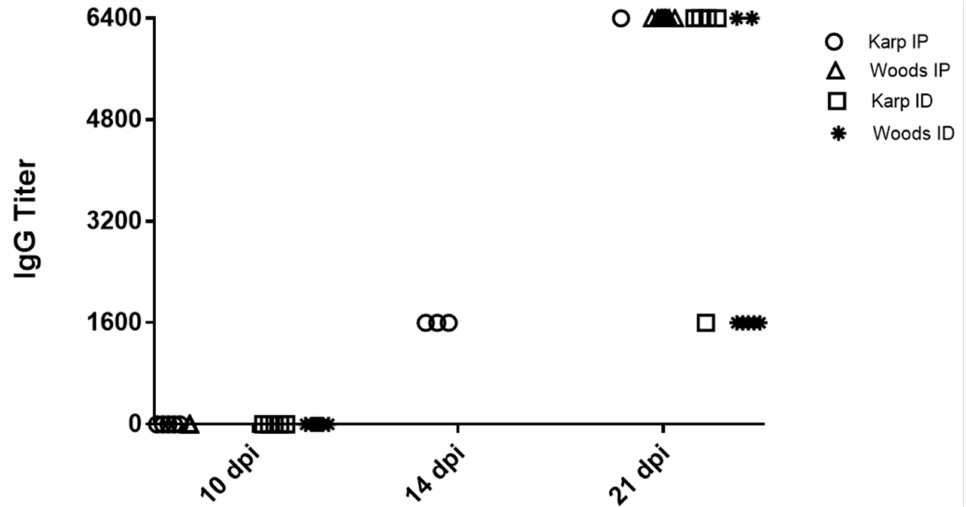
Figure 2. Detection of O. tsutsugamushi -specific IgG in serum of challenged mice at 10, 14, and 21 dpi. At 10 dpi, IgG was not detected in any of the challenged mice. At 14 dpi, 100% of Karp IP mice ( n = 3) (only mice assessed at 14 dpi). At 21 dpi, 100% of the mice (all strains and challenge routes) ( n = 5–8) displayed seroconversion. No O. tsutsugamushi -specific antibodies were detected in any of the negative control mice (data not